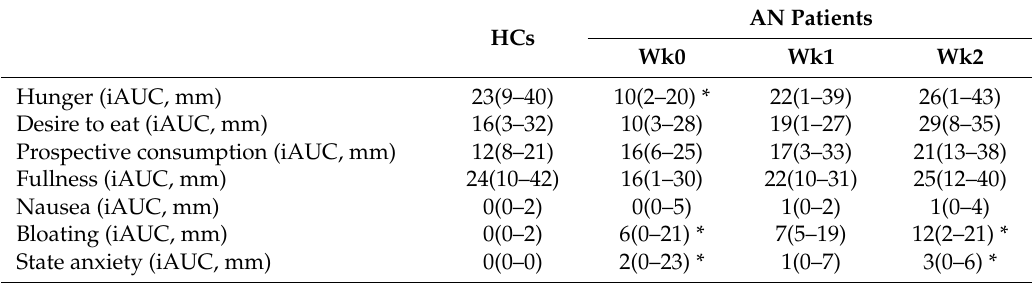
Table 2. Inverse incremental area under the curves (iAUCs) per minute for hunger, desire to eat and prospective consumption perceptions, and iAUCs per minute for fullness perceptions, GI symptoms and state anxiety 1